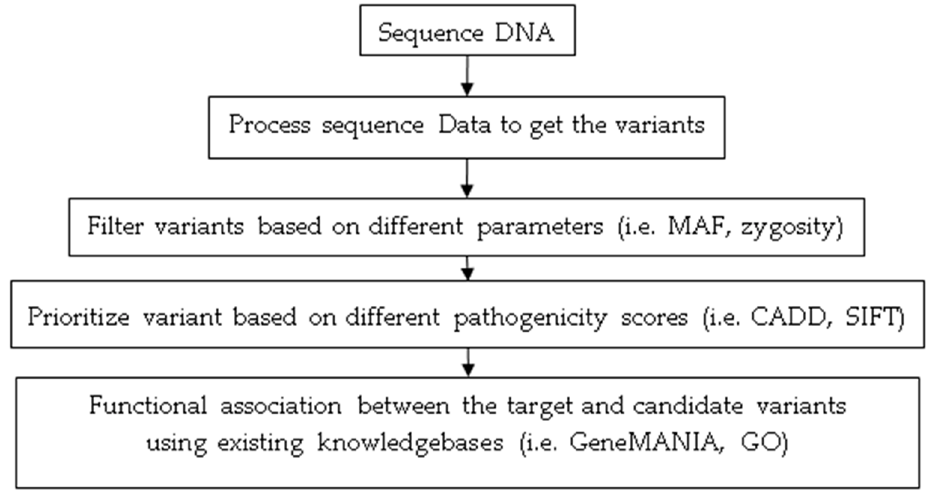
Figure 4. Typical analysis steps followed to identify modifiers using NGS based approaches in recent